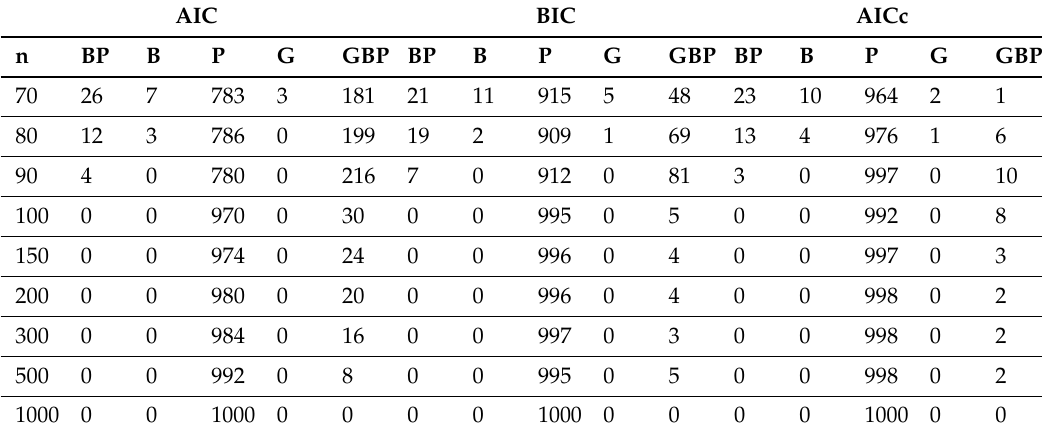
Table 8. Smaller AIC/BIC/AICc scores in 1000 simulations from a Pareto distribution P ( k , θ ) with k = 0.075, θ = 0.15.